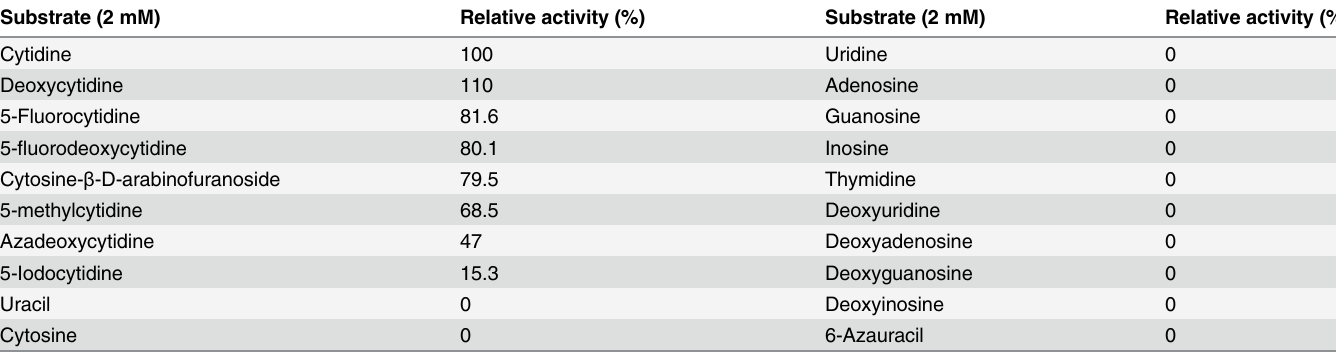
Table 2. Substrate specificity of the